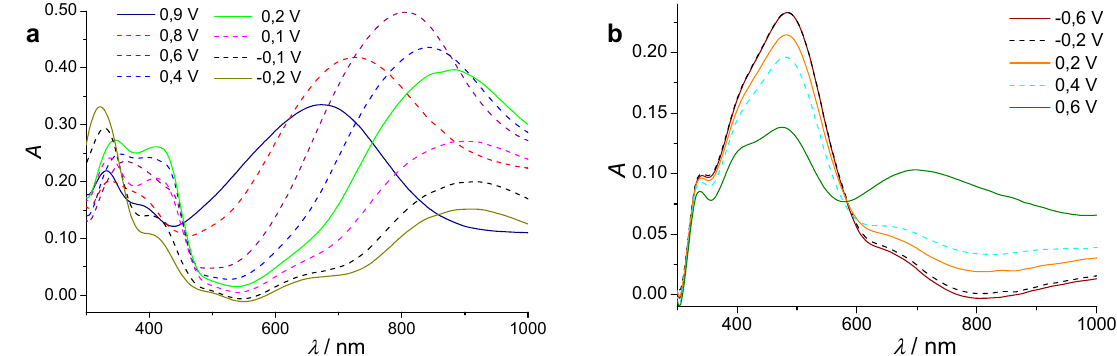
Figure 2. UV-VIS absorption spectra of ( a ) PANI and ( b ) PBTh deposited on fluorine-doped tin oxide (FTO) at di ff erent doping levels. Polymer films were placed in a 0.1 M KCl aqueous solution (for PANI-modified electrode) and 0.1 M tetrabutylammonium perchlorate solutions in MeCN (for PBTh-modified electrode) followed by application of different potentials for 10 s.